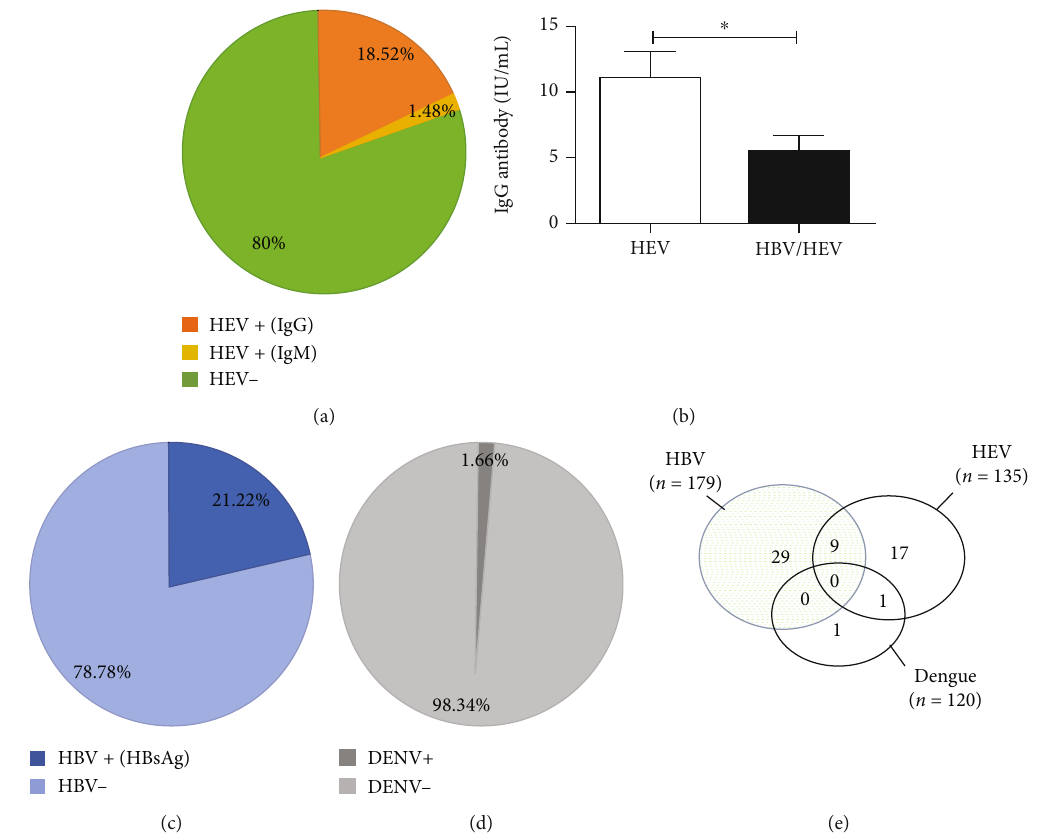
Figure 1: Seroprevalence data in the study population. (a) HEV seroprevalence and (b) anti-HEV IgG titers (IU/mL) compared between mono- and coinfected groups using the student unpaired t -test. ∗ Signi fi cant at p < 0 : 05 . (c) Seroprevalence of HBsAg. (d) DENV seroprevalence. (e) Venn diagram showing frequencies of monoinfection and coinfection hepatitis B and E and dengue in the study